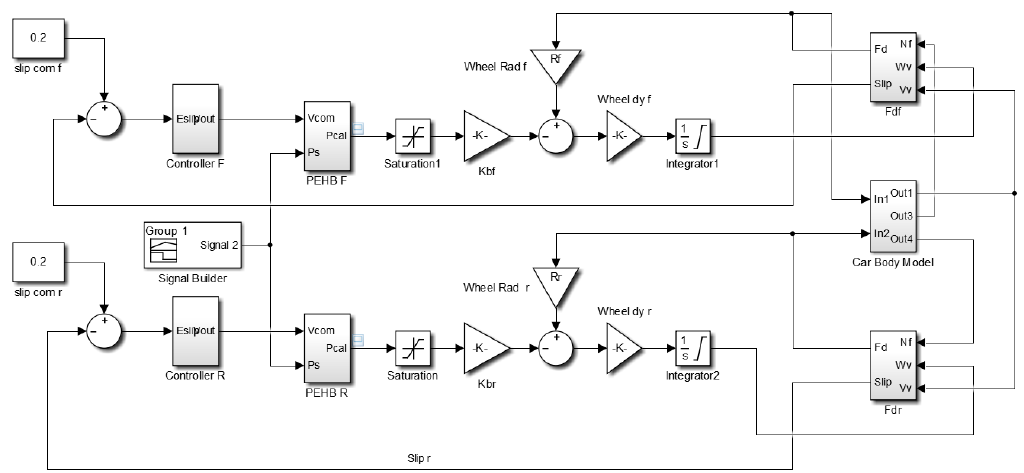
Figure 19. Motorcycle ABS simulation model with PEHB.